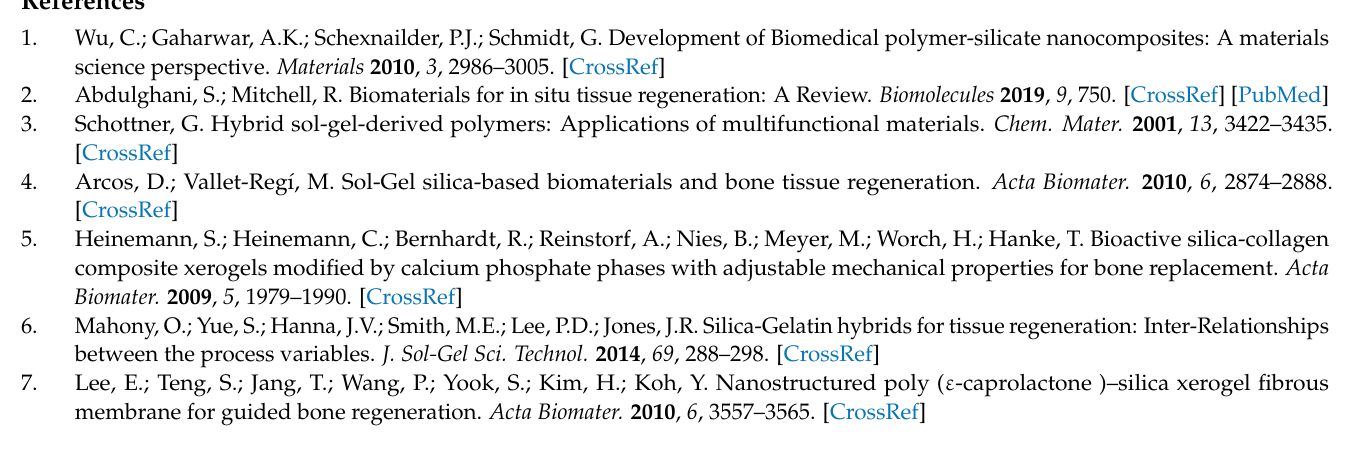
cell analysis. Live and dead data represent positive and negative controls, respectively, Table S4: Raw data from Table S3, Table S5: Significant differences between shape variables inter groups, Table S6: Pairwise differences between groups with 95% confidence